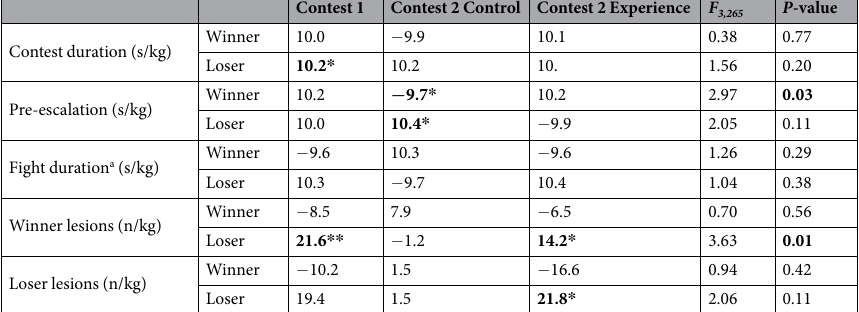
Table 4. Winner and loser RHP (body weight) in relation to various contest costs for contest 1, contest 2 control (no fighting experience except contest 1), and contest 2 of dyads that received profound fighting experience. Values are back-transformed beta estimates for the change in costs per kg of increase in body weight. The P -value indicates the significance of the change in the slope between the treatment groups. a Fight duration includes the contests with a fight only (n = 144) opposed to all contests (n = 270). * RHP significantly affects the contest costs by P < 0.05; ** by P <